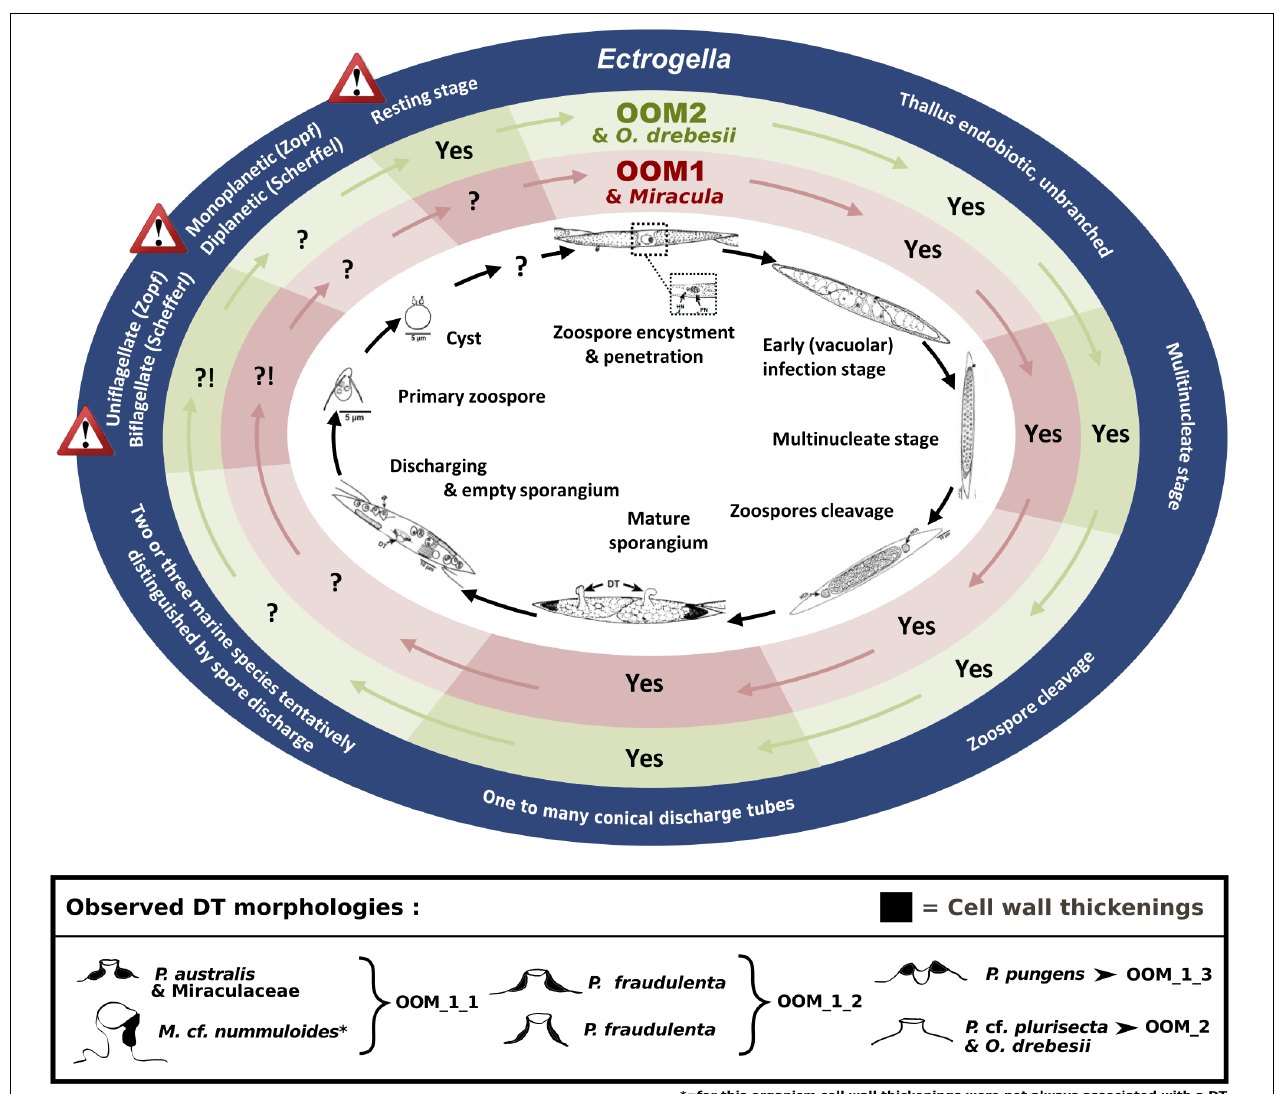
FIGURE 8 | Mapping observed OOM_1 and Miracula helgolandica (Buaya et al., 2017) and OOM_2 and Olpidiopsis drebesii (Buaya et al., 2017) life stages against Pseudo-nitzschia pungens oomycete parasitoid life cycle (Hanic et al., 2009) and the defining morphological criteria for the Ectrogella genus (Zopf, 1884; Scherffel, 1925). The development cycle of the oomycete parasitoid of P. pungens described by Hanic et al. (2009) is reproduced in the inner ellipse. The key morphological criteria defining the genus Ectrogella Zopf emend. Scherffel are highlighted in the external dark blue ellipse. The warning signs highlight contradictions between the original descriptions of the type species given by Zopf and Scherffel. The intercalary red and green ellipses highlight the congruence of each criterion (Yes) or lack thereof (?!, when morphology unknown or conflicting) between these original Ectrogella descriptions and the morphology of the OOM_1 and OOM_2 clades, respectively. The box at the bottom summarises the different DT morphologies as observed in different diatom hosts. Black colour highlights the cell wall thickenings (“forcing apparatus” sensu Sparrow,